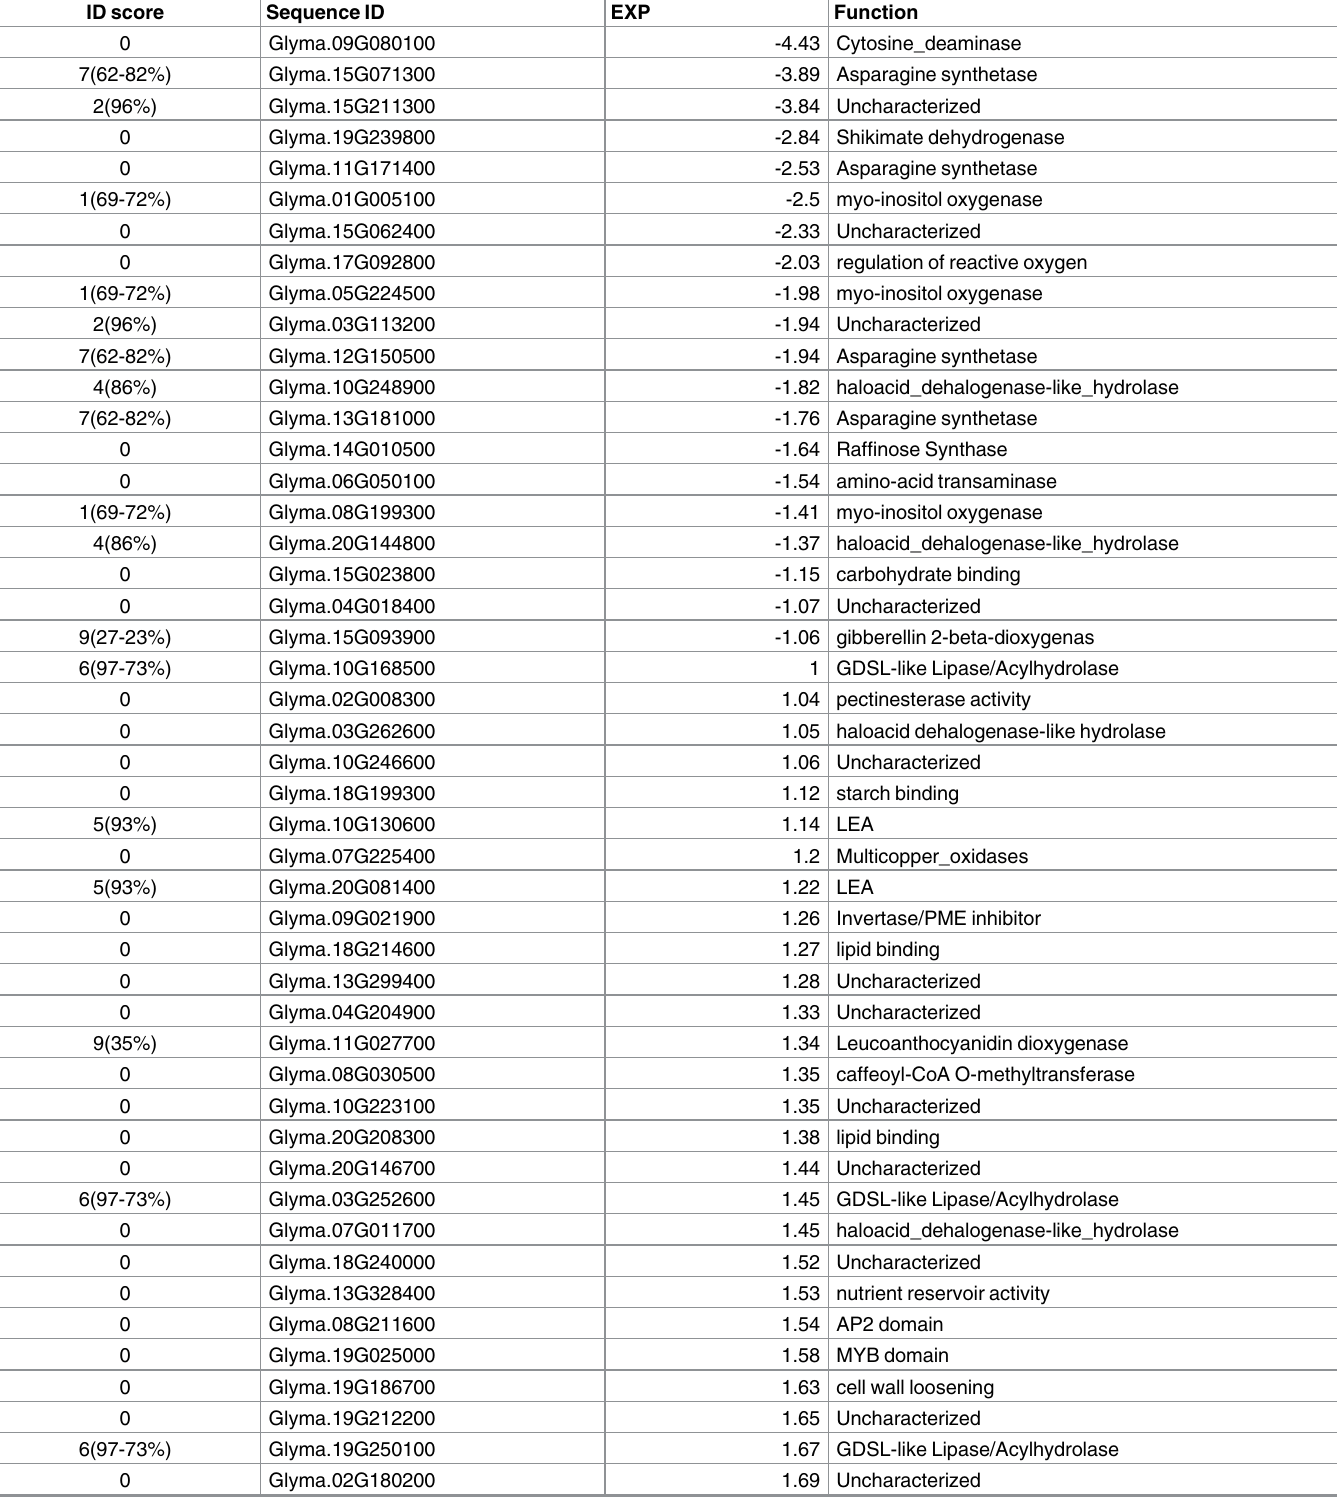
Table 7. Non-additive gene expressionin